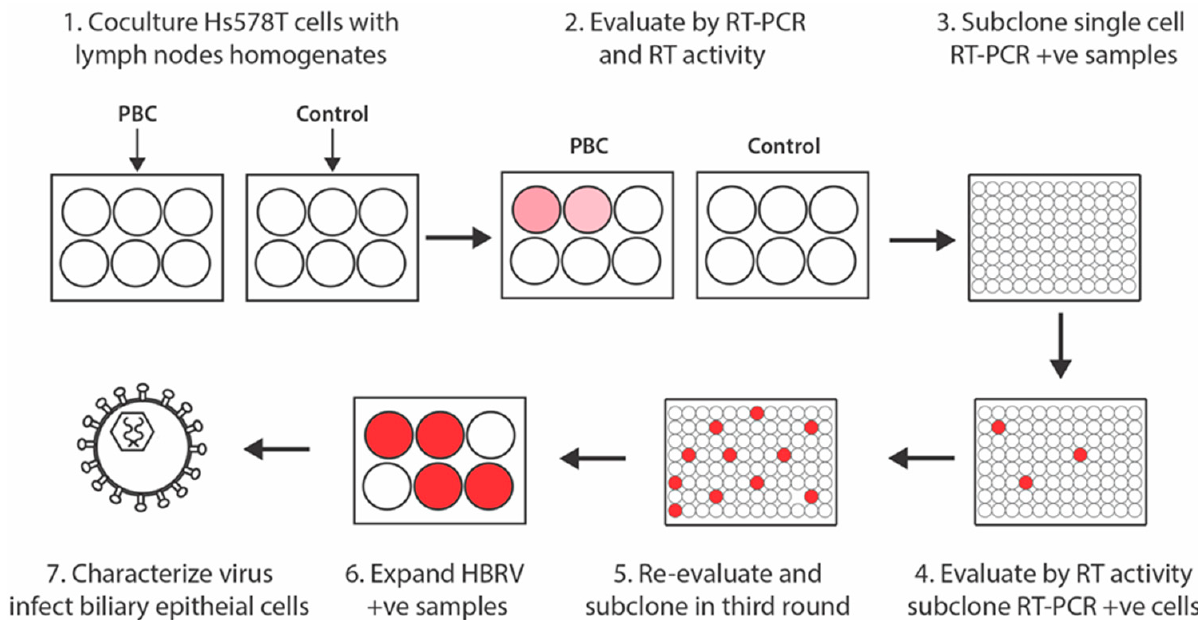
Figure 1. Isolation of HBRV by repeat subcloning of Hs578T cells infected with PBC lymph node homogenate. Co-cultures growing to 70% confluency with PBC lymph node homogenates were maintained in culture for 7 days. Then, three rounds of subcloning by limiting dilution of single cells exposed to PBC conditioned media, supernatants were assayed for RT activity and HBRV RT- PCR positive cells were subcloned for a total of three rounds [Pink and red circles represent increas- ing HBRV load with subcloning infected Hs578T cells].